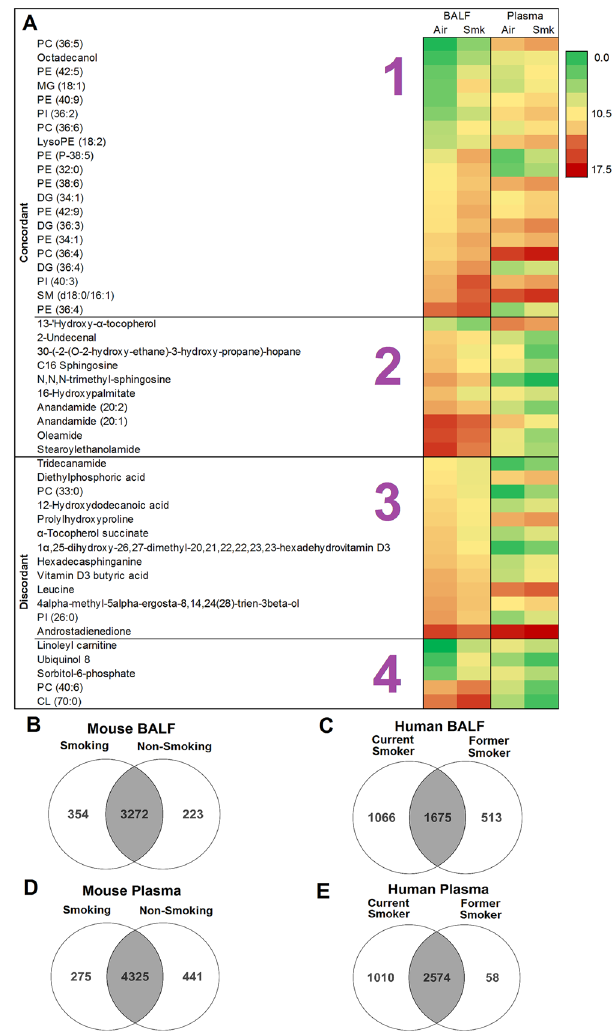
Figure 4. Metabolome changes in response to cigarette smoke. ( A ) Heat map of statistically significant and differentially regulated metabolites in mouse BALF and plasma in response to cigarette smoke compared to air control groups (n = 7/group). Metabolite abundances range from 0 (green) to 17.5 (red). Statistical analysis was performed in Mass Profiler Professional 13.1 (Agilent) using Storey with Bootstrapping q ≤ 0.1 and fold change ≥ 1.5. CL: cardiolipin, PE: phosphatidylethanolamine, PC: phosphatidylcholine, PI: phosphatidylinositol, SM: sphingomyelin, MG: monoglyceride, DG: diglyceride. The four sections of the heat map are as follows: 1 – metabolites are up-regulated in both BALF and plasma, 2 – metabolites are down-regulated in both BALF and plasma, 3 – metabolites are down-regulated in BALF and up-regulated in plasma, 4 – metabolites are up- regulated in BALF and down-regulated in plasma in response to CS-exposure. ( B ) Overlap of metabolites in BALF from smoking and non-smoking mice. (C) Overlap of metabolites in human BALF from current and former smokers. ( D ) Overlap of metabolites in plasma from smoking and non-smoking mice. ( E ) Overlap of metabolites in human plasma from current and former